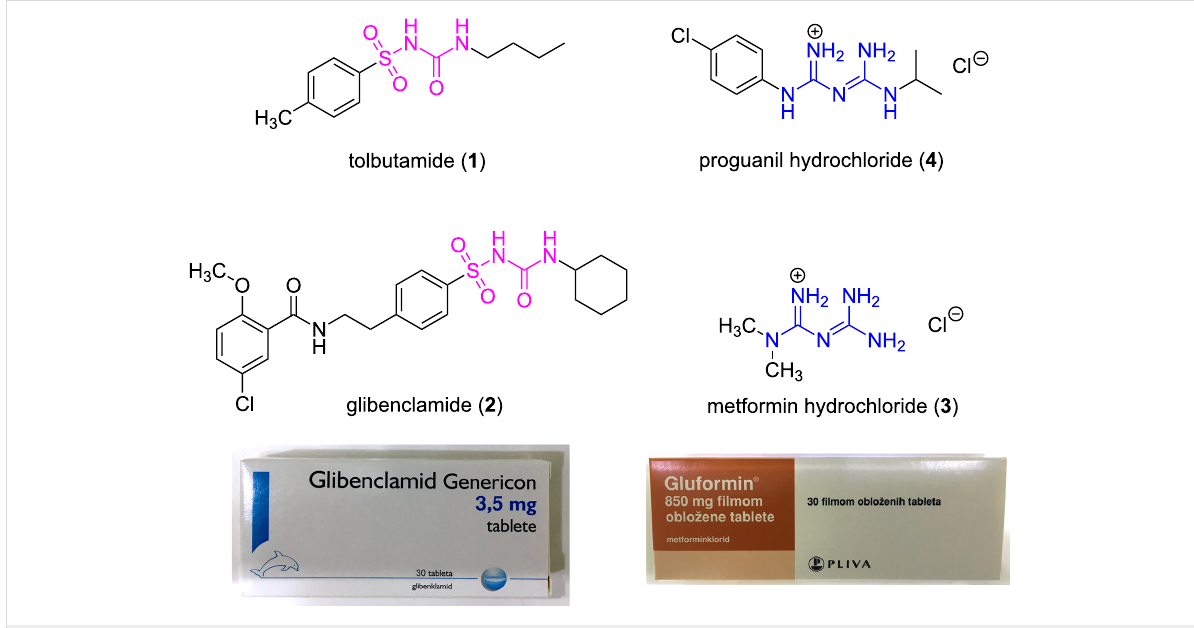
Figure 1: Antidiabetic ( 1–3 ) and antimalarial ( 4 ) drugs derived from ureas and guanidines currently available in the market.